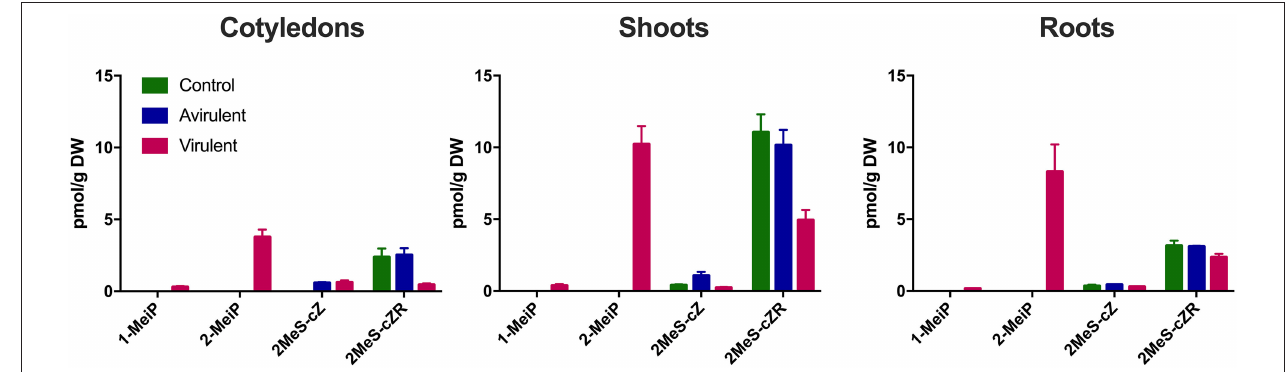
FIGURE 5 | Comparison of four cytokinins (pmol/g DW) in cotyledons, shoots and roots 15 days post-inoculation with R. fascians virulent strain 602, avirulent strain 589, or mock inoculation (Control). The error bars are ± s.d. of four biological replicates. that both the mt1 and mt2 genes are present in all R. fascians